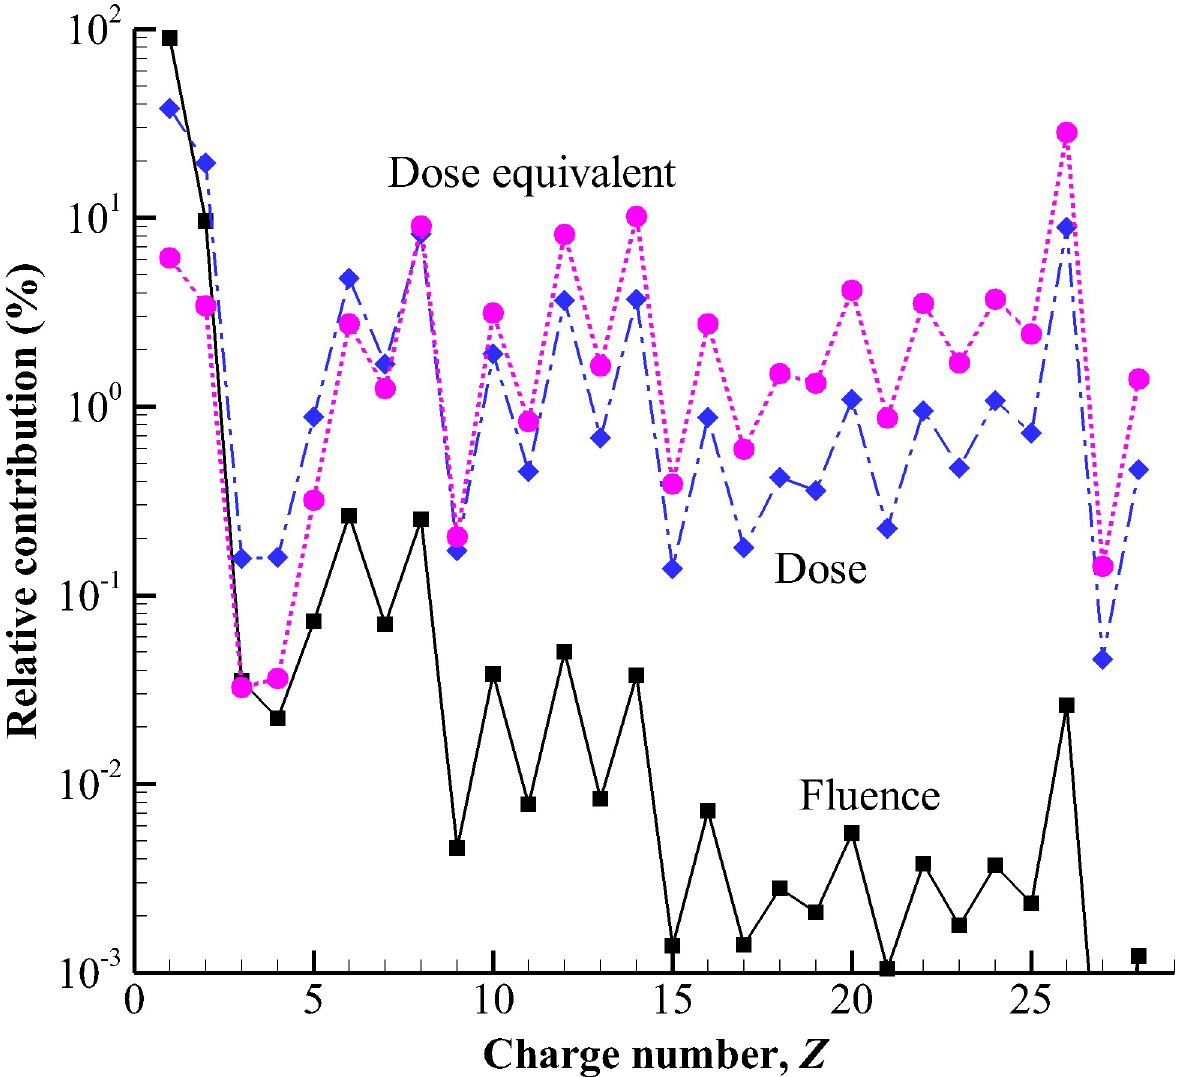
Fig 2. Relative contribution to fluence (squares), dose (diamonds), and dose equivalent (circles) of different elements in the free-space GCR environment during solar minimum conditions (June 1976) as described by the Badhwar–O’Neill 2010 GCR model [14] (Adapted from Durante and Cucinotta [3]). Plot data available in S1 Data. GCR, galactic cosmic radiation.